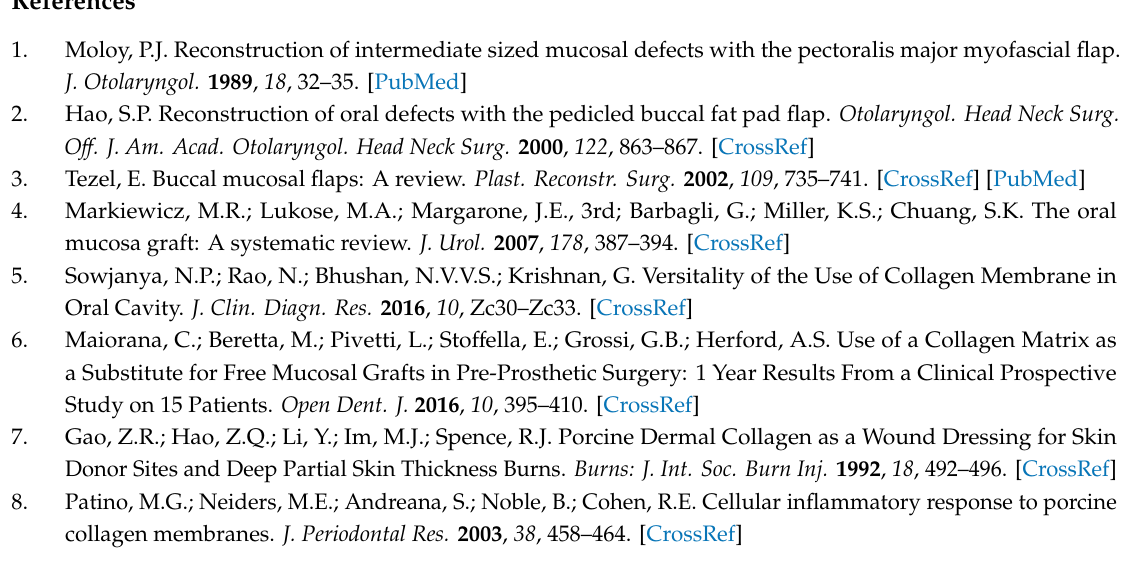
Figure S1: L929 cells grown on the laser-welded membrane +